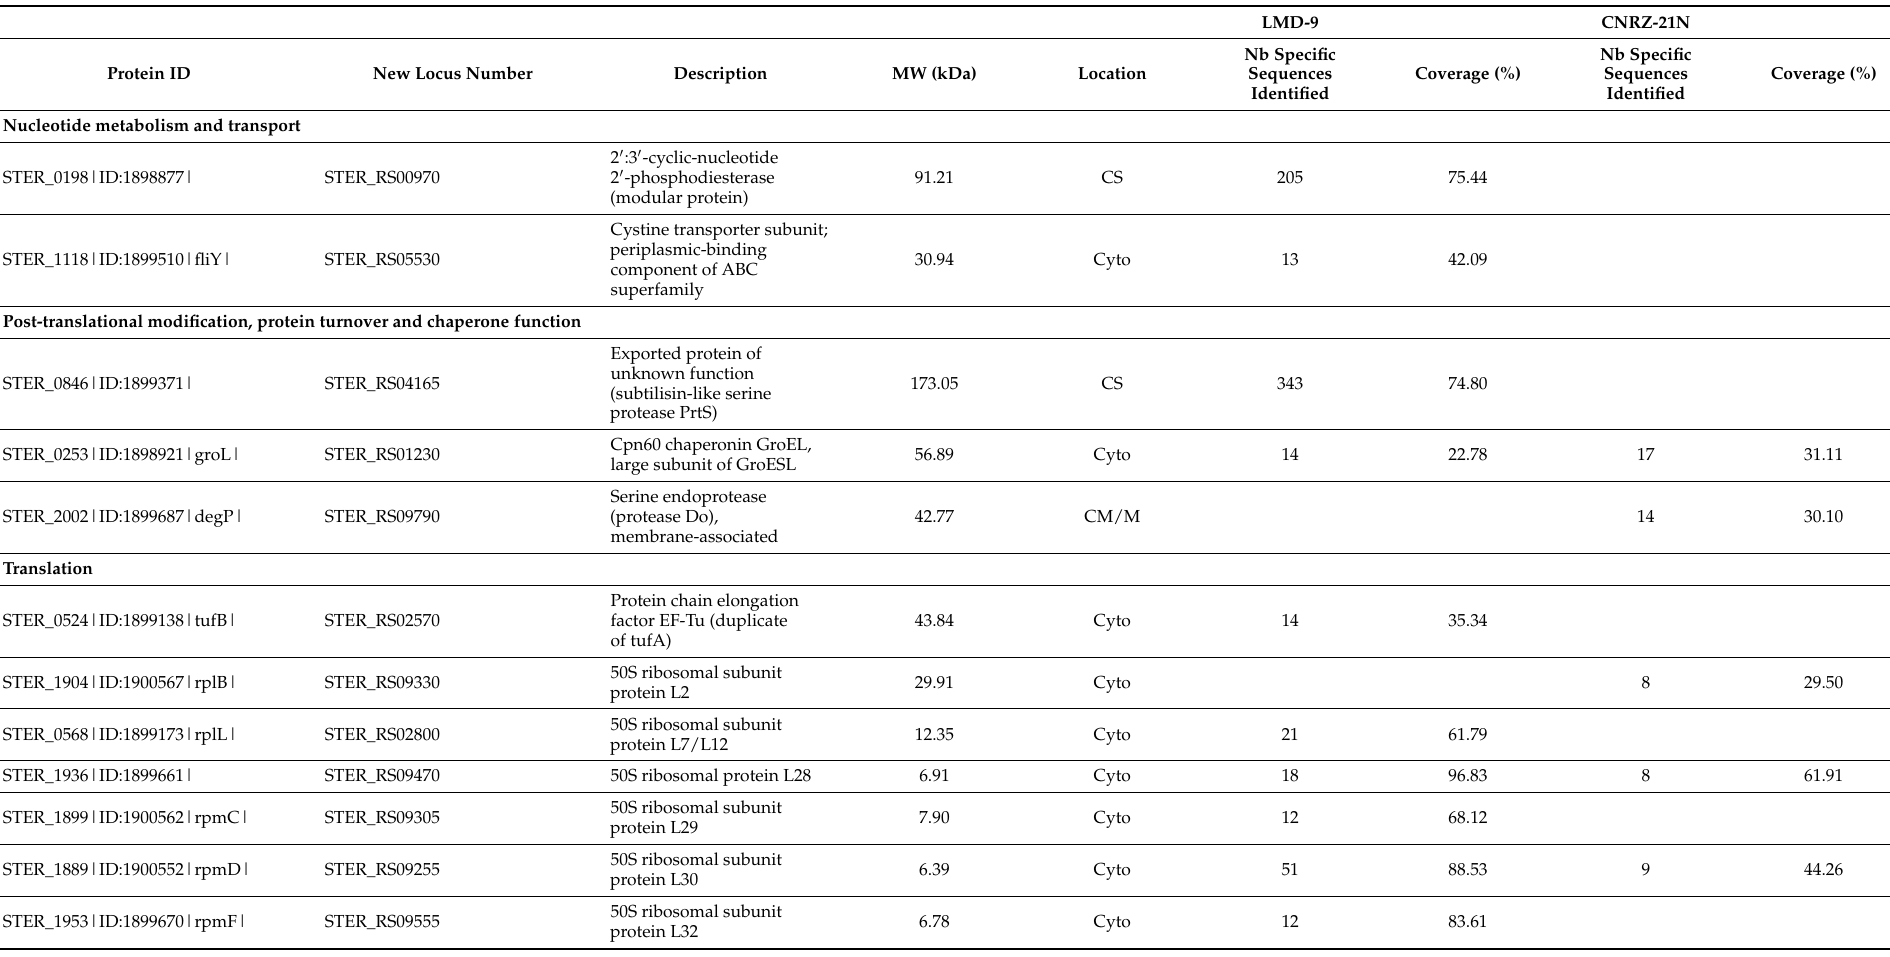
Table 1. Identification of proteins via LC-MS/MS analysis of peptides obtained after peptic shaving of S. thermophilus LMD-9 and